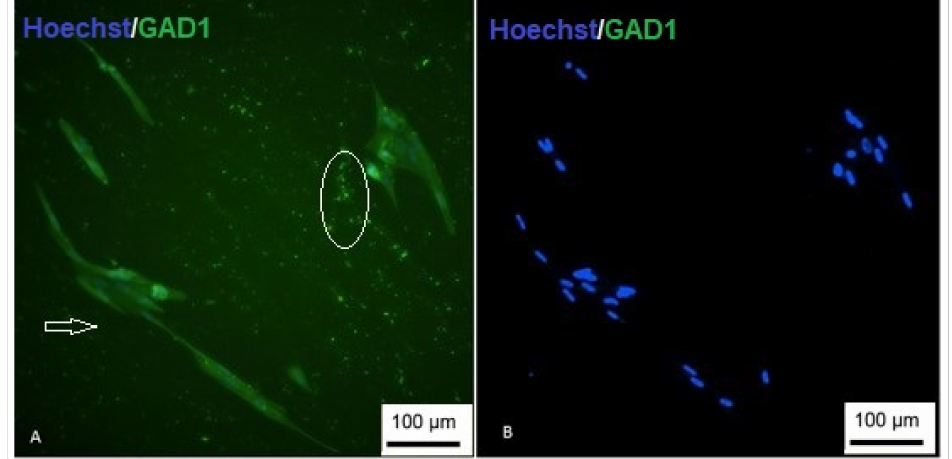
Figure 17. Immunocytochemistry of GABAergic differentiation. ( A ) Cells are showing nuclear staining (blue) and positive staining for GAD1 (green); ( B ) undifferentiated control (inverted optical microscopy—200 × ). Scale bar, 100 µ m.